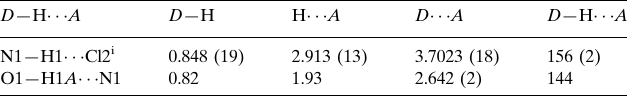
Hydrogen-bond geometry (A˚ , (cid:1)